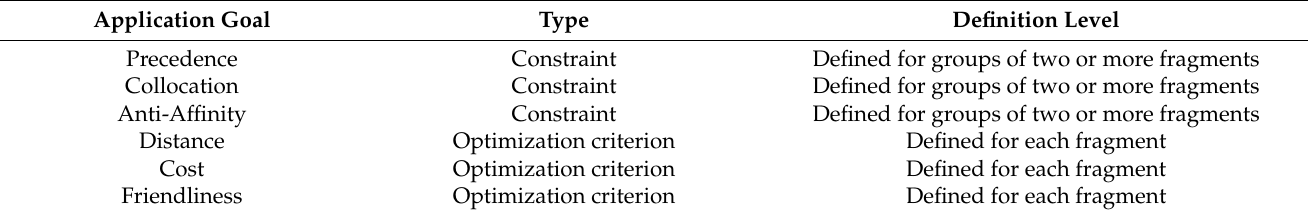
Table 4. Fragment goals (optimization criteria and constraints) available to be defined by the DevOps. Application Goal Type Definition Level Precedence Constraint Defined for groups of two or more fragments Collocation Constraint Defined for groups of two or more fragments Anti-Affinity Constraint Defined for groups of two or more fragments Distance Optimization criterion Defined for each fragment Cost Optimization criterion Defined for each fragment